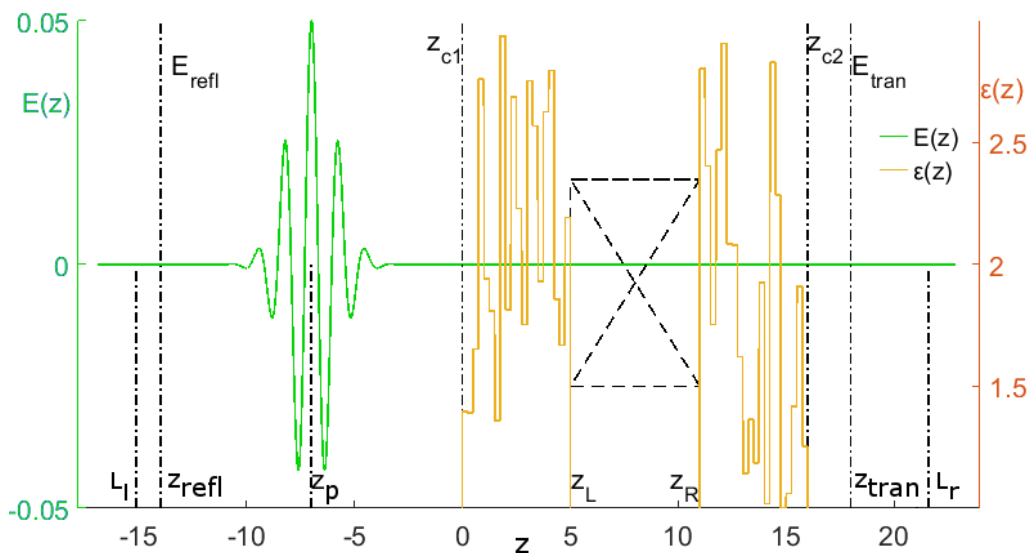
Figure 4. The scheme of the THz pulse interaction with covered substance. The left coordinate axis shows the electric field strength in dimensionless units. The dielectric permittivity of layers is shown on the right axis. The crossed rectangle depicts the active medium. Lines marked as E refl and E trans denote the coordinates at which the reflected and transmitted THz pulses are measured.